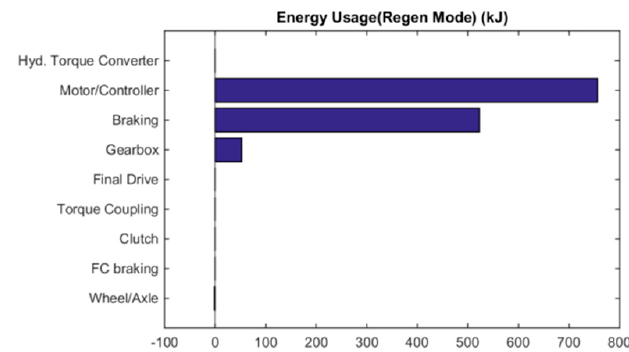
Figure 22. Energy use power mode.